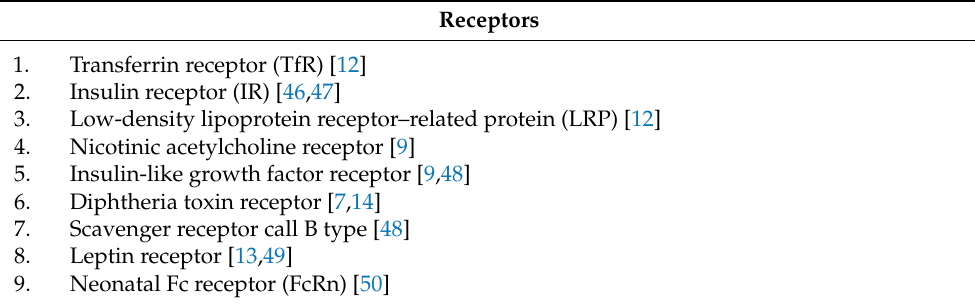
Table 2. Receptor-mediated targets (RMT) for transport at the blood–brain barrier. Part of this table is reproduced from Gao (2016) with permission of the copyright owner